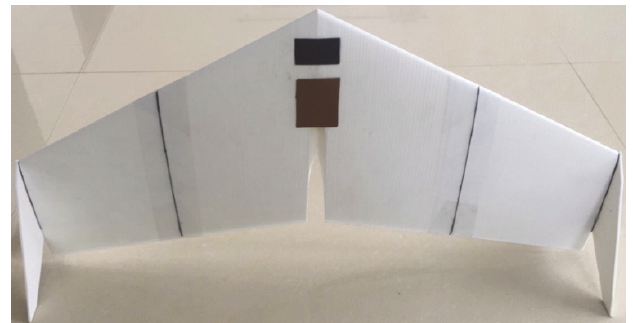
Figure 6. Wind tunnel experimental prototype.